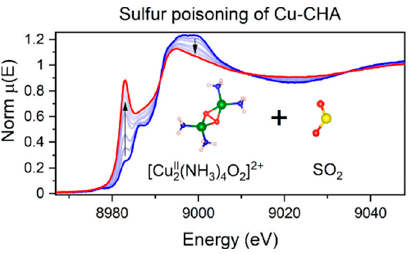
Figure 6. Cu K-edge XAS collected in situ during the exposure of the Cu species obtained to SO 2 . In a typical NH 3 -SCR reaction, urea injection can be identified in the downstream sulfur atmosphere, and the co-adsorption of ammonia sulfate and Cu-S substance must be considered. Jangjou [33] found that when feeding gas containing a mixture of SO 2 , NH 3 , and NO, NH 3 facilitated SO 2 adsorption on Cu-SAPO-34 at 200 ◦ C. Sulfur was stored on zeolite and co-adsorbed with NH 3 , which resulted in the formation of ammonium sulfate. On the one hand, the DRIFT results showed that in the absence of NH 3 , Cu 2+ resided at the six-membered ring and was completely poisoned by sulfur and partially poisoned at the eight-membered ring in a typical NO adsorption reaction [35,36]. On the other hand, the co-adsorbed ammonium sulfate could be consumed by NO in the SCR reaction [36]. Shen [37] proved that no matter which sulfate was generated at the active sites, the decrease in the active sites of isolated Cu 2+ mainly accounted for the decrease in activity. Wijayanti et al. [38] studied the sulfate species on Cu-CHA and found that (NH 4 ) 2 SO 4 and CuSO 4 formed at 200 and 400 ◦ C, respectively, on the isolated Cu 2+ active sites. Both led to deactivation over Cu-CHA [39,40]. It was proven that two kinds of active Cu species exist on Cu/CHA, namely Cu 2+ -2Z and [Cu (OH) + ]-Z [40–43]. As shown in Figure 7, Jangjou [33] pointed out that Cu 2+ -2Z had a different low-temperature SO 2 poisoning mechanism compared with [Cu (OH) + ]-Z. Cu 2+ -2Z active sites were less reactive with SO 2 . However, when SO 2 and NH 3 co-existed in a typical SCR reaction, NH 3 and SO 2 could react at a low temperature and decompose below 550 ◦ C. On the contrary, SO 2 reactively adsorbed with [Cu (OH) + ]-Z and formed CuHSO 3 , which could be composed below 580 ◦ C. Above that, CuHSO 3 was oxidized to CuHSO 4 with gaseous oxygen feeding. Meanwhile, CuHSO 4 required a relatively high decomposition temperature, i.e., 750 ◦ C, according to DFT calculation and FTIR measurement. In addition, this mechanism was further proven by Hannershoi [44] through quantitative identification of EPR. Olsson et al. proposed a kinetic model of SO 2 poisoning and regeneration in which the copper resided in the six-membered rings (S1Cu), and copper in the larger CHA cages (S2 and S3) adsorbed SO 2 and formed S1 Cu -SO 2 and S 2 -SO 2 . In addition, NH 3 was adsorbed on those sites and formed S1 Cu -SO 2 -(NH 3 ) 2 and S2-SO 2 -(NH 3 ) 2 complexes, which worked as precursors of (NH 4 ) 2 SO 4